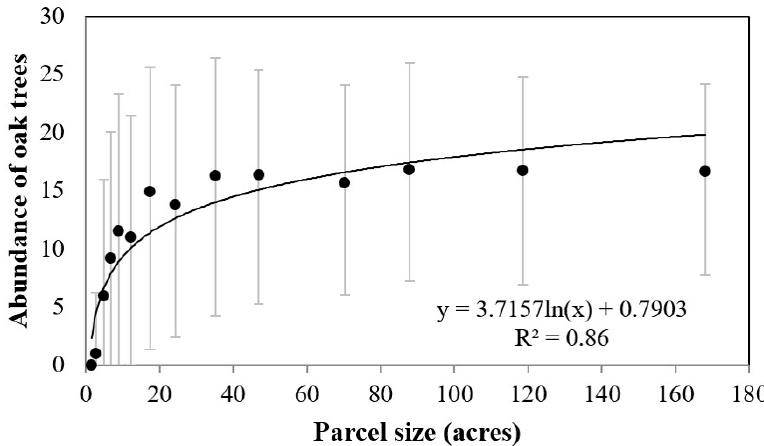
Figure 10. Abundance of oak trees versus parcel size. The black point is the mean value of each bin, the error bar is the 0.25–0.75 percentiles, and the solid line is the regression line.